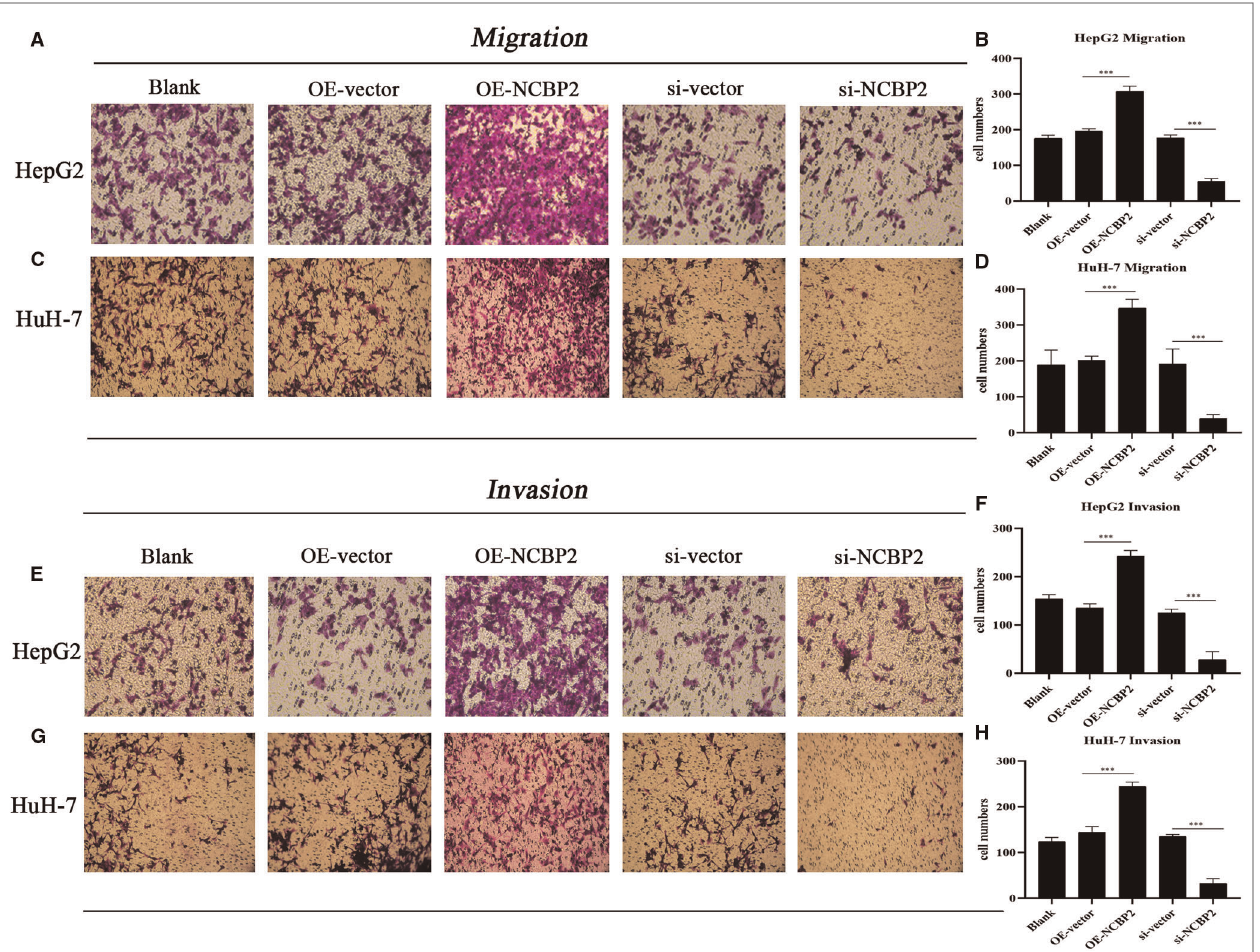
FIGURE 9 | Overexpression of NCBP2 promotes the migration and invasion of LC cells. ( A,B ) Results of transwell migration assays in HepG2 and HuH-7 cells. ( C,D ) Migrative cell numbers in different experimental groups. ( E – G ) Results of transwell invasion assays in HepG2 and HuH-7 cells. ( F,H ) Invasive cell numbers in different